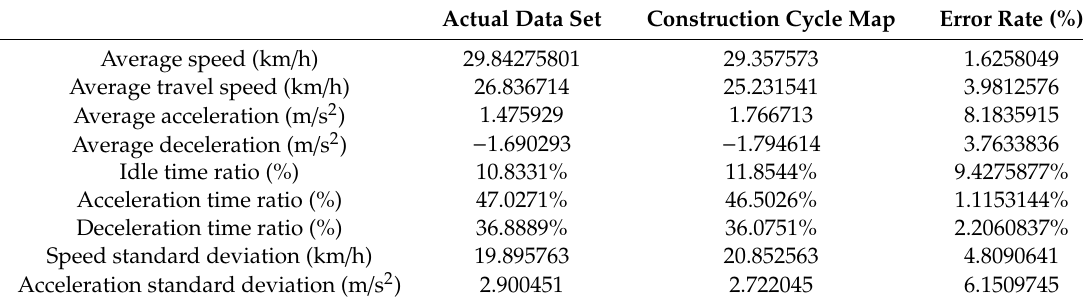
Table 5. Comparison of the driving cycle map and the actual data set parameters.